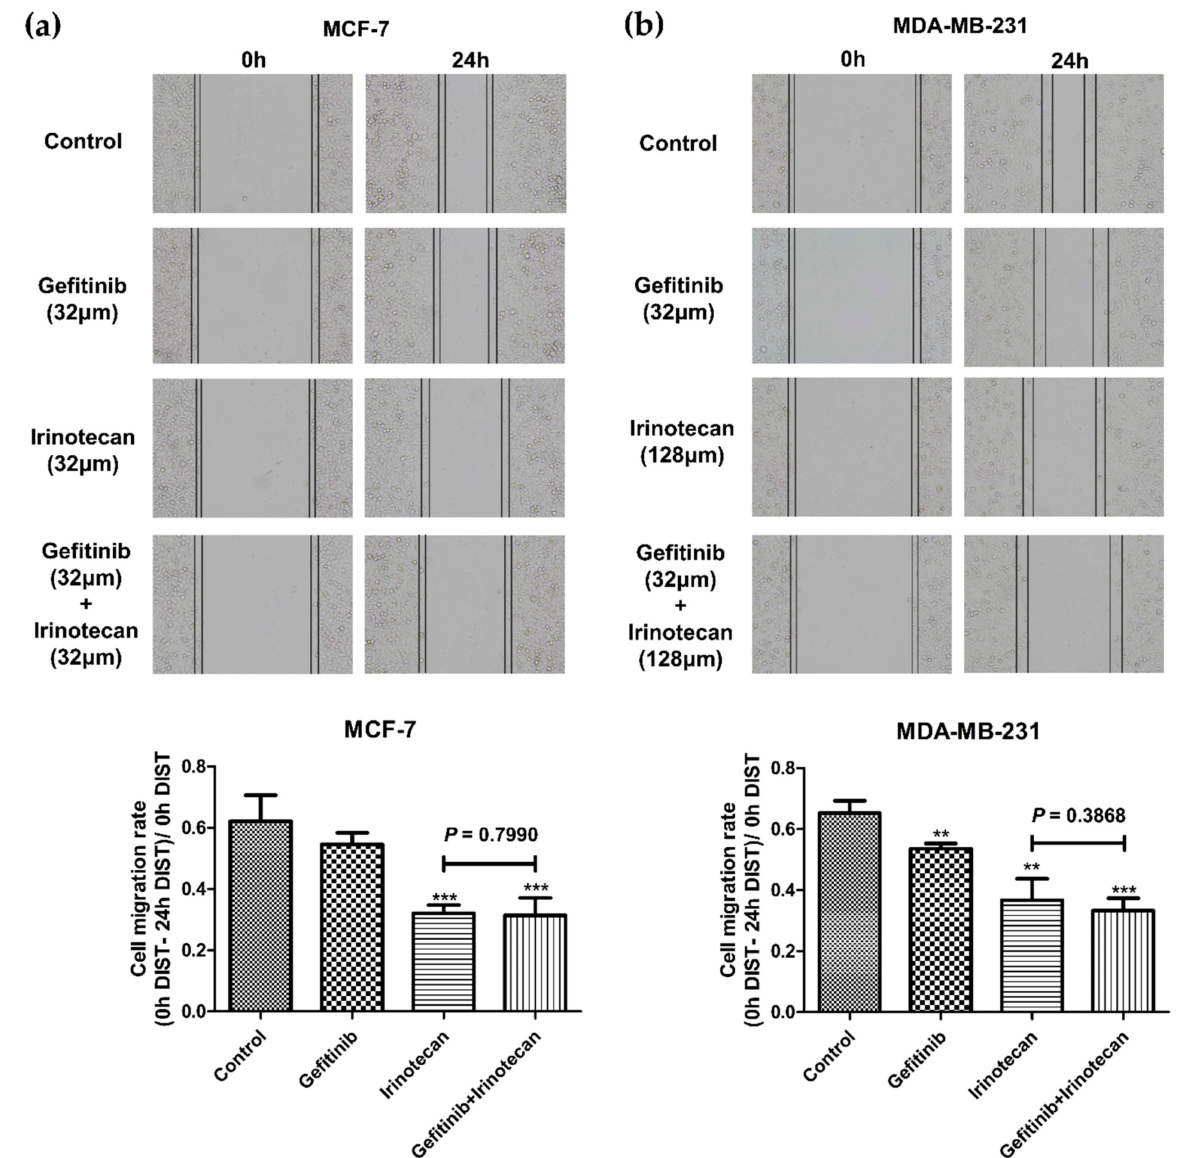
Figure 5. Effects of gefitinib and irinotecan on the migration of BC cell lines. The cell migration rate was calculated as (0 h distance–24 h distance)/ 0 h distance. ( a ) In the MCF-7 cell line, the cell migration rates of the gefitinib, irinotecan, and gefitinib plus irinotecan groups were significantly lower than that of the control group at 24 h, while there was no significant difference between the gefitinib plus irinotecan group and the irinotecan group. ( b ) In the MDA-MB-231 cell line, the cell migration rates of the gefitinib, irinotecan, and gefitinib plus irinotecan groups were significantly lower than that of the control group at 24 h, and the migration rate of the gefitinib plus irinotecan group was significantly lower than that of the irinotecan group. * p < 0.05, ** p < 0.01, and *** p < 0.001, as compared with the control